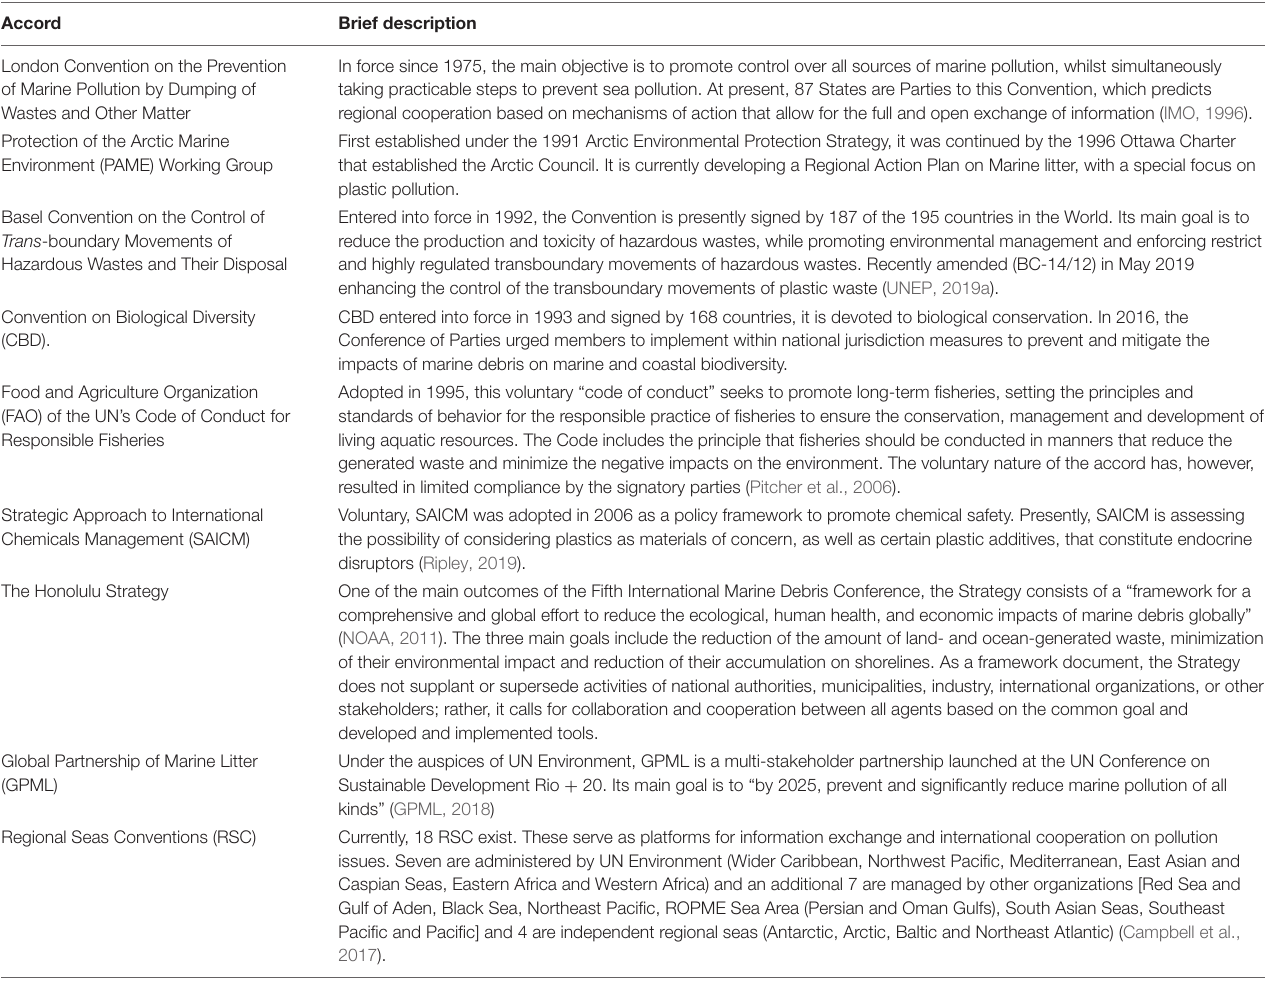
TABLE 1 | Additional regional treaties, agreements and conventions for the management of marine litter and